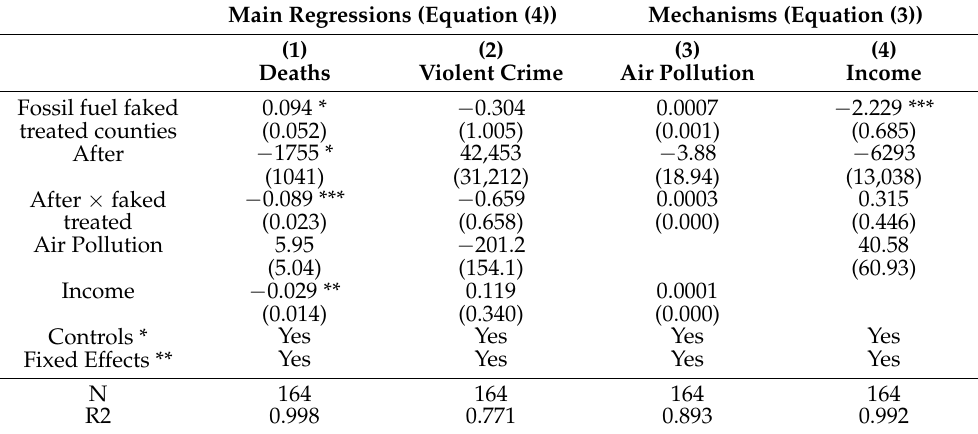
Table 7. Placebo test to detect the true effect in Table 3 with the randomly selected 16 counties from Alaska, Colorado, and North Dakota, instead of the treatment counties in California, Massachusetts, and Washington.